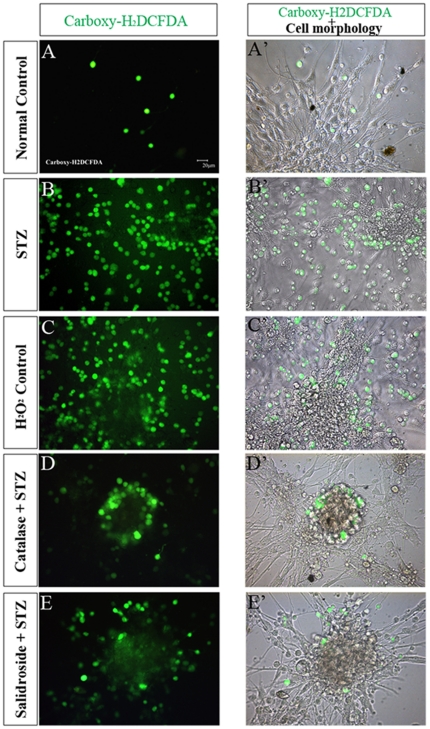
Detection of intracellular ROS with a fluorescent probe carboxy-H2DCFDA.Representative photomicrographs showing ROS (reactive to the green fluorescent probe carboxy-H2DCFDA) within the cytoplasm of NSCs (A–E) and merged images showing both ROS immunoreactivity and cell morphology (A′–E′) in five experimental groups: Normal control group (A-A′), STZ group (B-B′), H2O2 control group (C-C′), Catalase+STZ group (D-D′) and Salidroside+STZ group (E-E′).